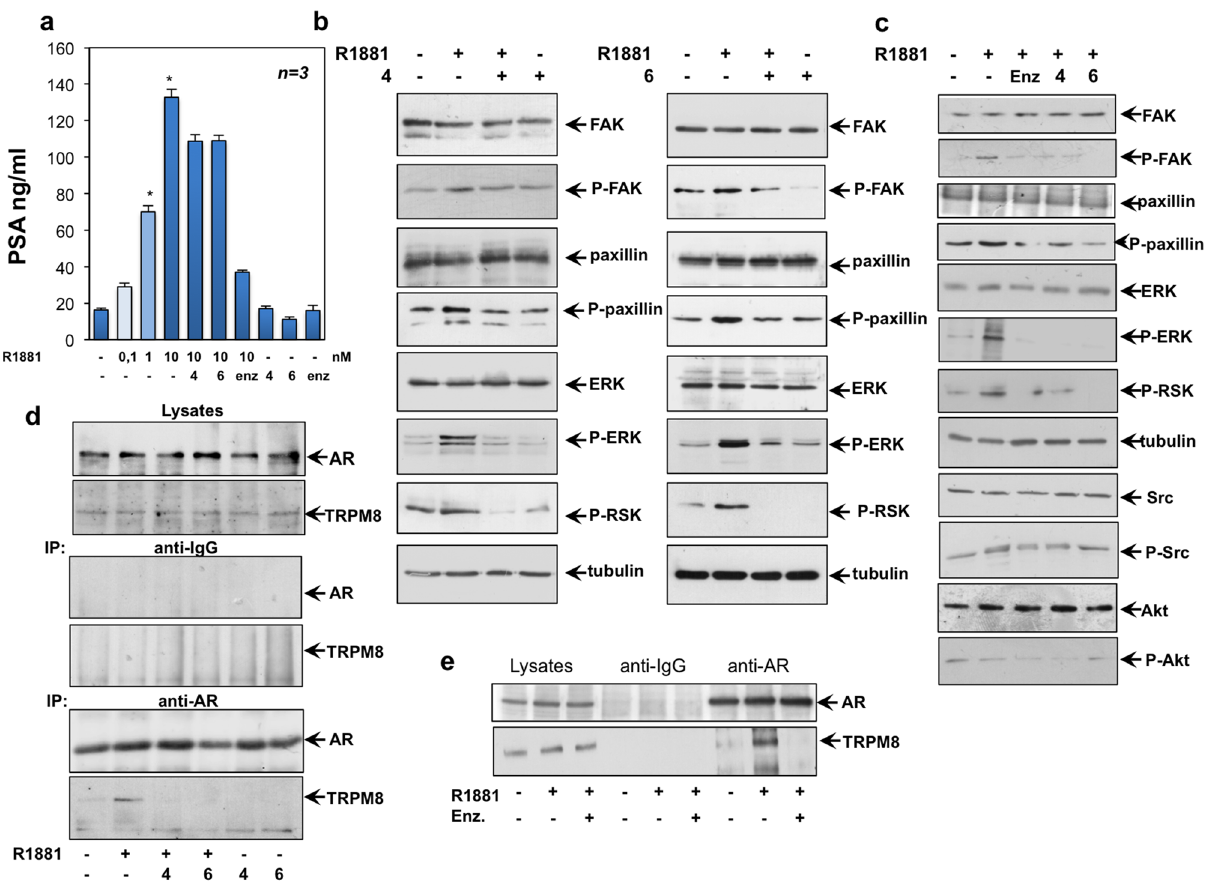
Figure 6. TRPM8 antagonists inhibit the rapid androgen action by disrupting the ligand-induced AR/TRPM8 complex assembly in LNCaP cells. In ( a–e ), quiescent LNCaP were used. When indicated the compounds 4 and 6 were used at 1 μM. Enzalutamide (enz) was added at 10 μM. In ( a ) , cells were left untreated or treated with increasing R1881 concentration (0,1, 1 or 10 nM), in the absence or presence of the indicated compounds for 48 h. Conditioned media were collected and PSA was assayed as described in “Methods”. Means and SEMs from three different experiments are shown. *p < 0.05 for the indicated experimental points versus the corresponding untreated control. In ( b – e ), cells were unstimulated or stimulated with 10 nM R1881, in the absence or presence of the indicated compounds for 10 min. Lysate proteins were analyzed by WB technique using the antibodies against the indicated proteins. P-FAK stands for Tyr 397-P-FAK; P-paxillin stands for Tyr 118-P-paxillin; P-RSK stands for P-Ser 380 RSK; P-ERK stands for phospho-p44/42 MAPK (Erk1/2) (Thr202/Tyr204); P-Src stands for P-Tyr 416 Src and P-Akt stands for P-Ser 473 Akt. The filters were stripped and re-probed using anti tubulin antibody, as loading control. In the upper panel in ( d ) and left section in ( e ), lysate proteins were analyzed by WB using the antibodies against AR or TRPM8. Lysate proteins were immunoprecipitated using the anti-AR antibody (anti-AR, lower panel in ( d ) and right section in ( e ) or control IgG (anti-IgG; middle panel in ( d ) and middle section in e ). Proteins in immune-complexes were revealed by WB using the antibodies against the indicated proteins. Results in ( b–e ) are representative of 3 different experiments and the densitometric analysis is reported in Supplementary